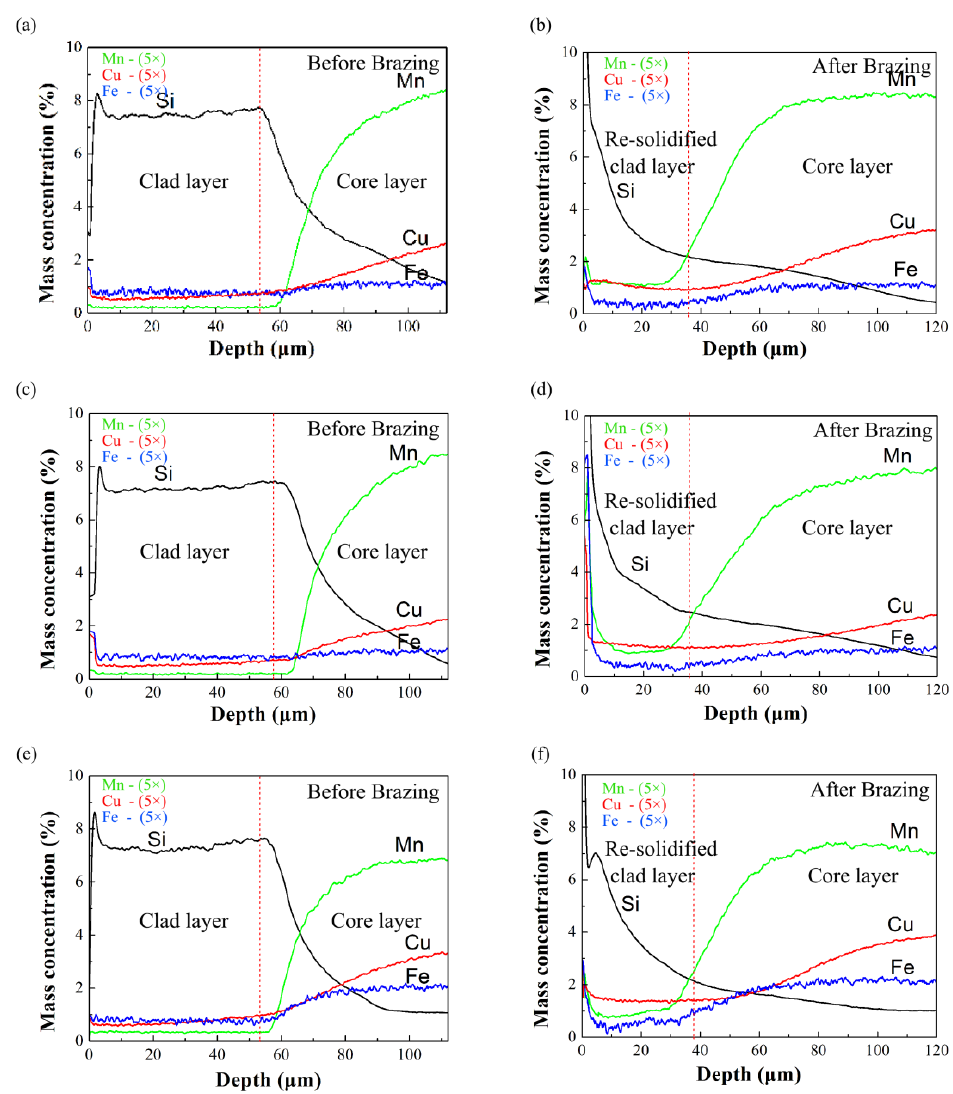
Figure 12. GDOES profiles of the three experimental alloys ( a , c , e ) before and ( b , d , f ) after brazing, ( a , b ) Sample A, ( c , d ) Sample B, ( e , f ) Sample C. The red-dotted line in the figures represents the interface between the clad material and the core material. (Due to the huge difference between the contents of different elements, the mass concentrations of Mn, Fe and Cu in the figures are magnified by 5 times).